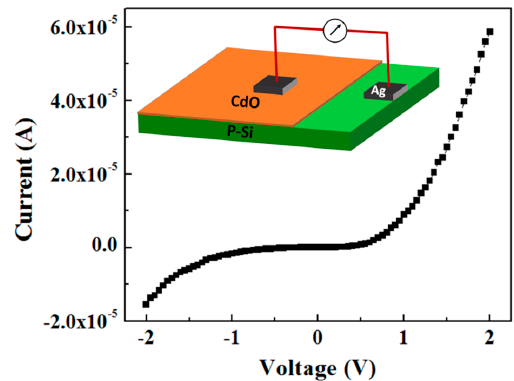
Figure 12. Dark I-V plot of an n-CdO/p-Si heterostructure. The inset shows the schematic view of the fabricated device.